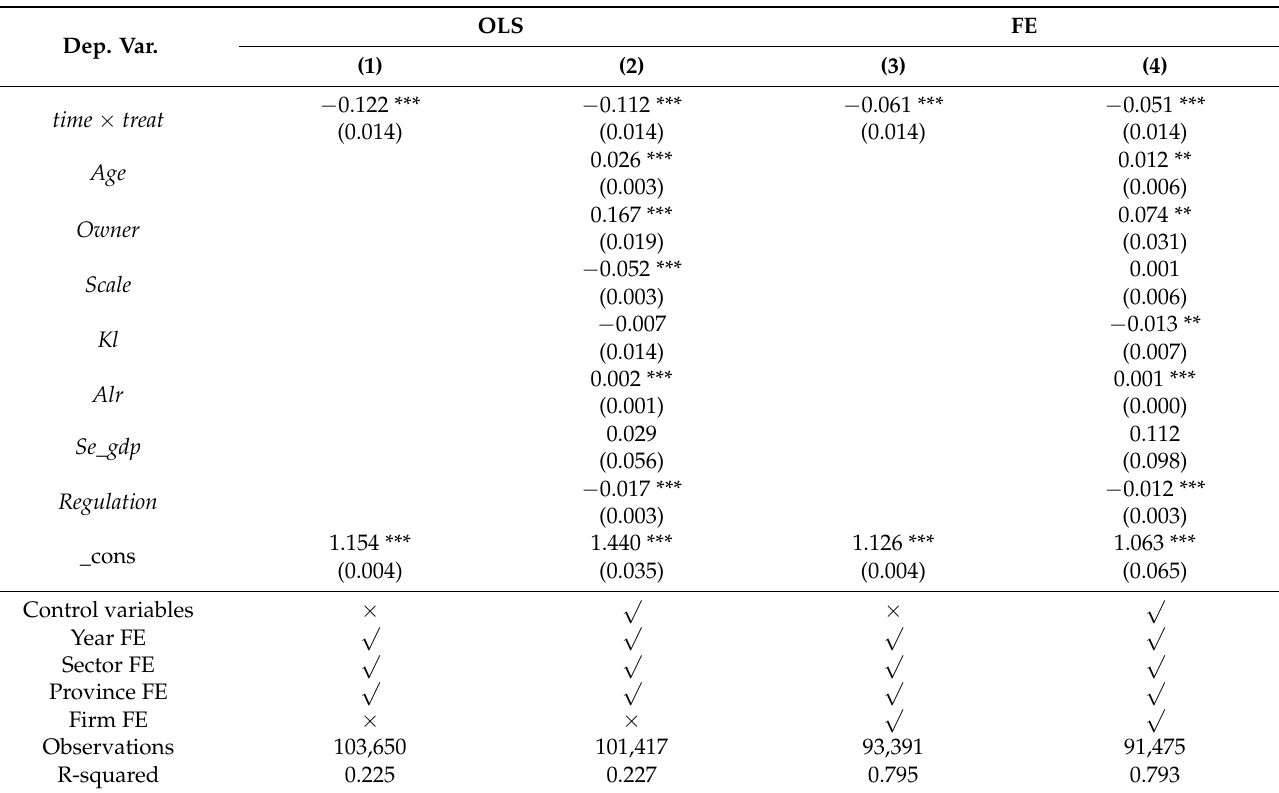
Table 4. Benchmark